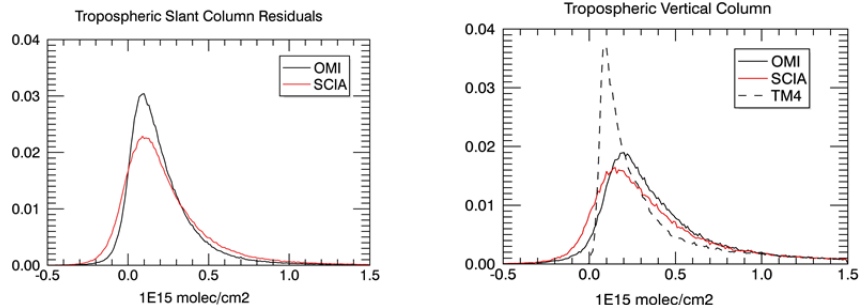
Figure 11. Histogram of global tropospheric NO 2 columns from OMI and SCIAMACHY nadir (normalized slant column N s on the left, and vertical column N v on the right) for 2005 with CRF < 50% – uncorrected for diurnal variation. The OMI and SCIA global median normalized slant column N s is 0.20 and 0 . 21 ( 0 . 13 and 0 . 13 mode ) × 10 15 moleculescm − 2 , respectively. The OMI and SCIA global median vertical column N V is 0.30 and 0 . 26 ( 0 . 20 and 0 . 15 mode ) × 10 15 moleculescm − 2 , respectively. The median tropospheric column for the